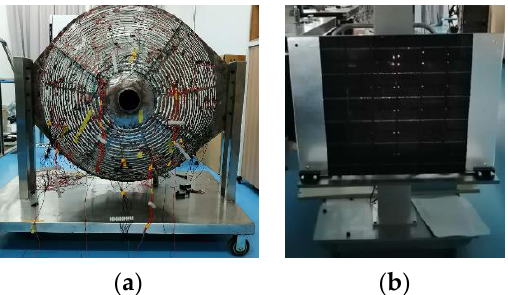
Figure 11. Comparison experiment: ( a ) powersphere, ( b ) photovoltaic panel.